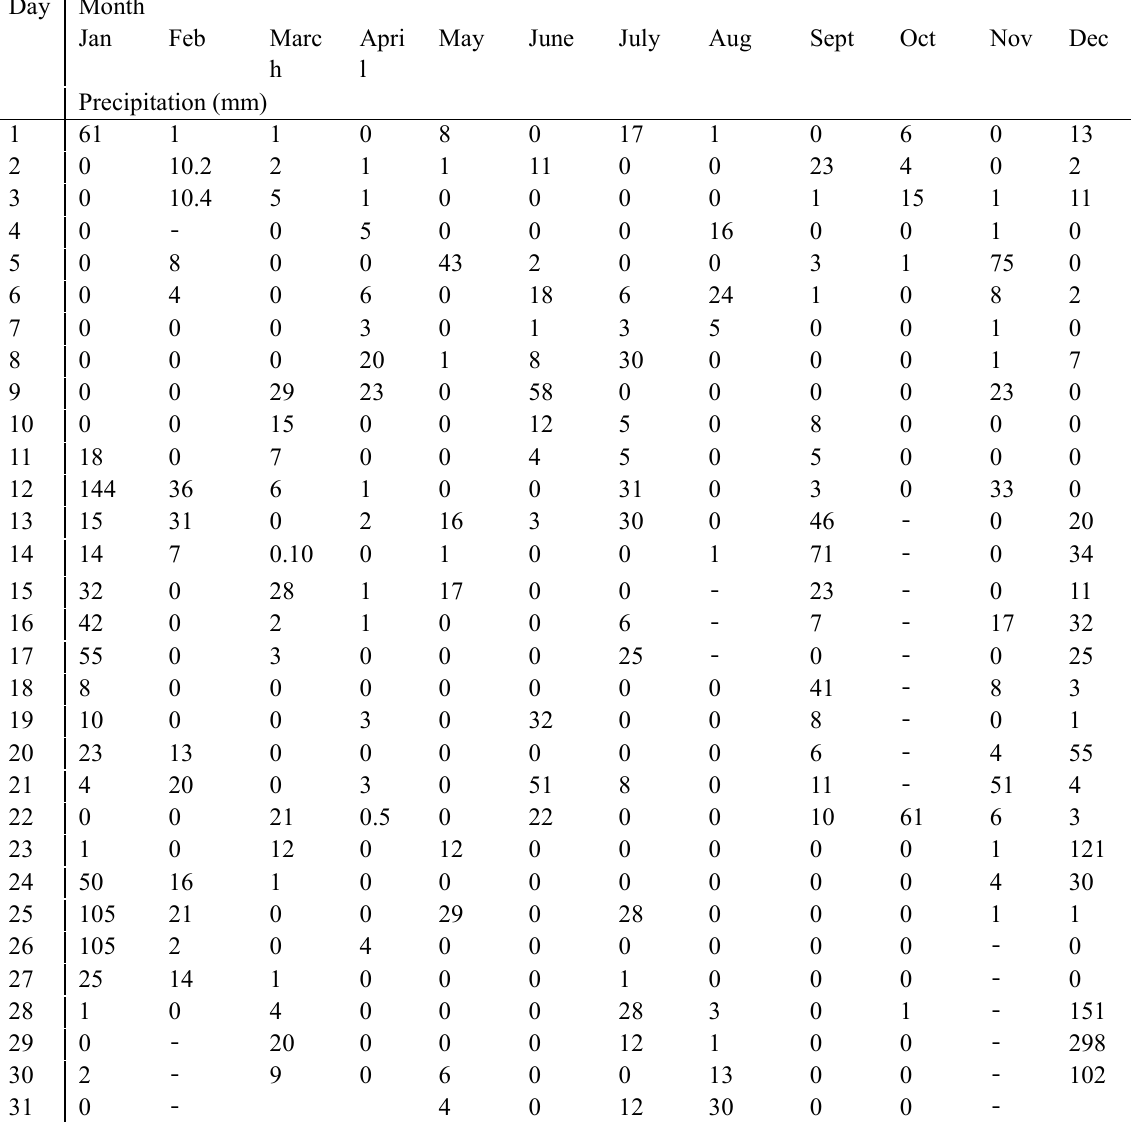
Daily precipitation of year